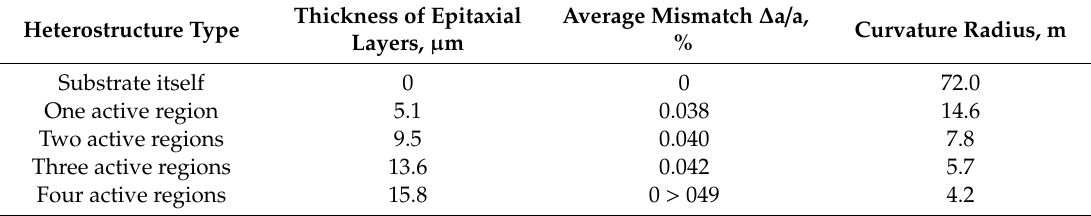
Table 1. Dependence of the curvature radius from structure thickness and total lattice mismatch. Heterostructure Type